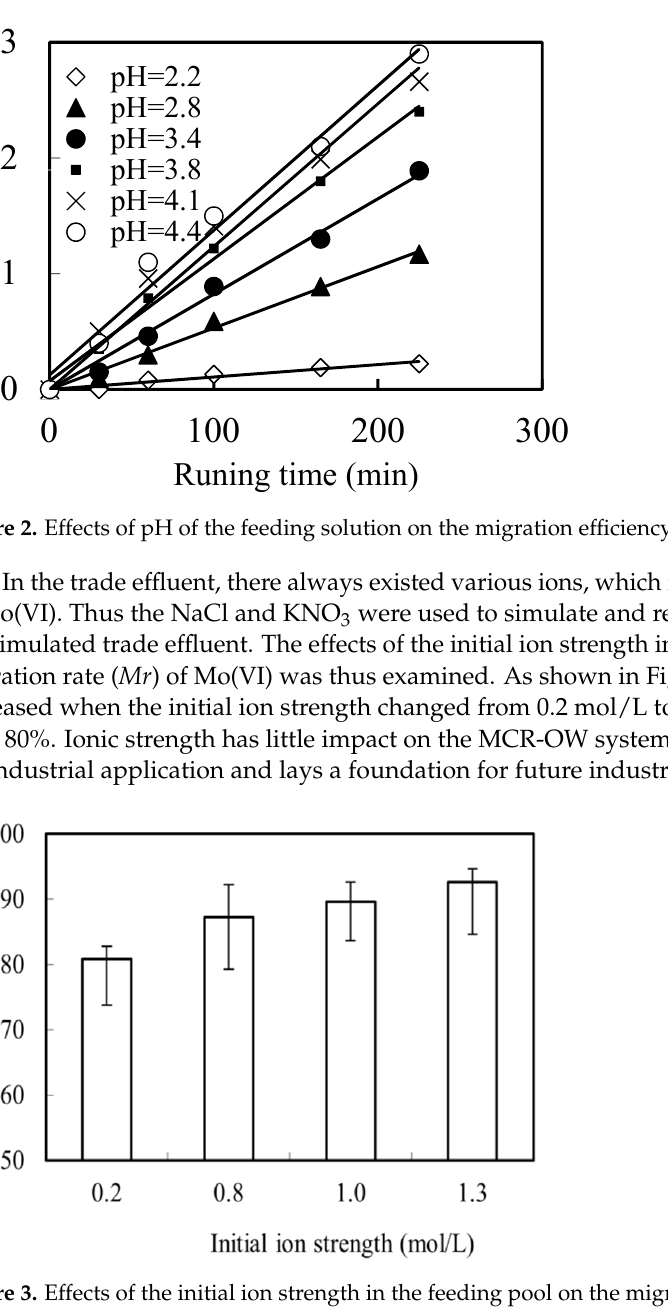
Figure 3. Effects of the initial ion strength in the feeding pool on the migration rate ( Mr ) of Mo(VI).